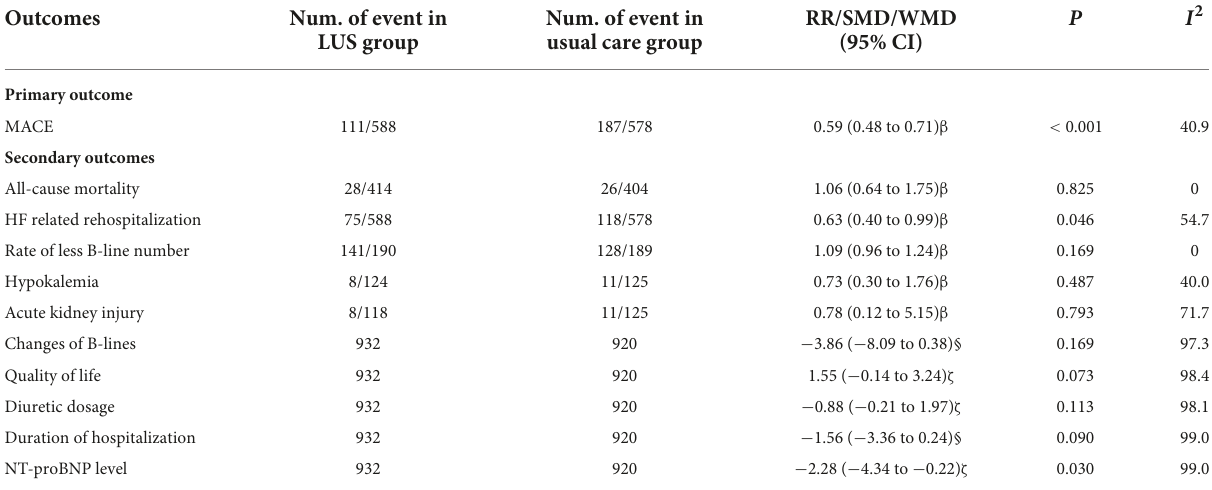
Num. of event in RR/SMD/WMD LUS group usual care group (95%